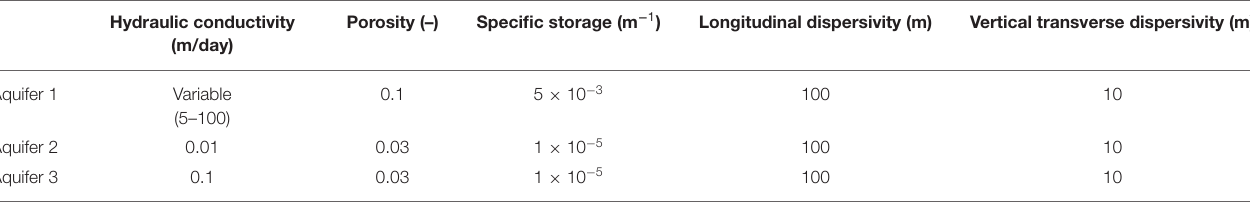
TABLE 1 | Aquifer properties for the 2D vertical slice VDST model. Hydraulic conductivity